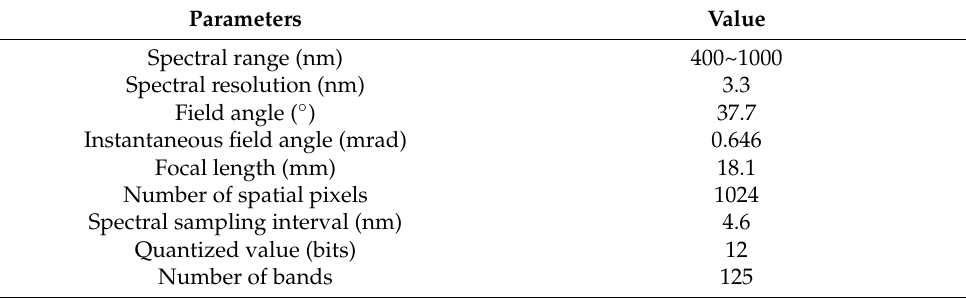
Table 2. The main spatial parameters of hyperspectral